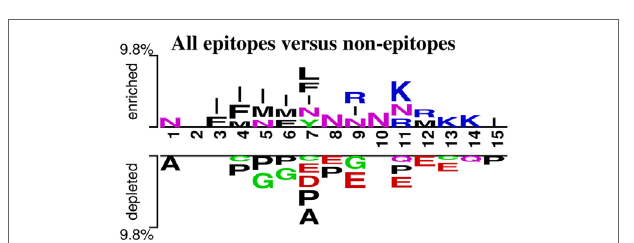
FigUre 4 | Two-sample logo created using epitopes and non-epitopes in all the data ( p -value < 0.01). The immunogenicity motifs for epitopes and non-epitopes were derived from the combination of all the datasets.